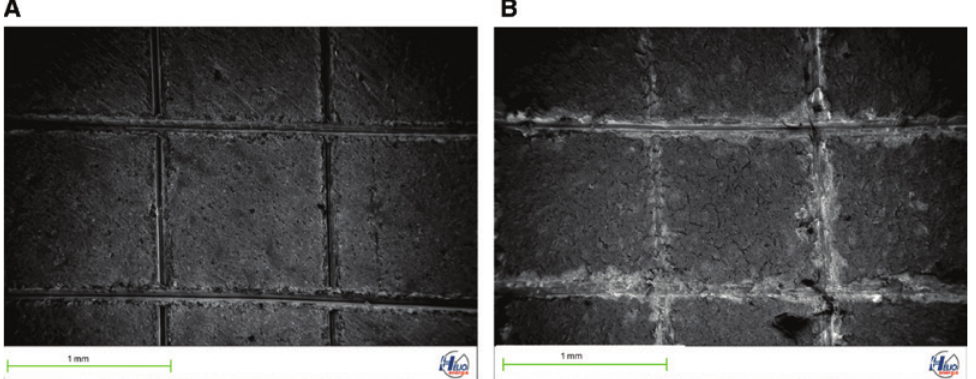
Figure 2: Lattice of silver layer cuts on the aluminium surface: class 0 (A) and class 4